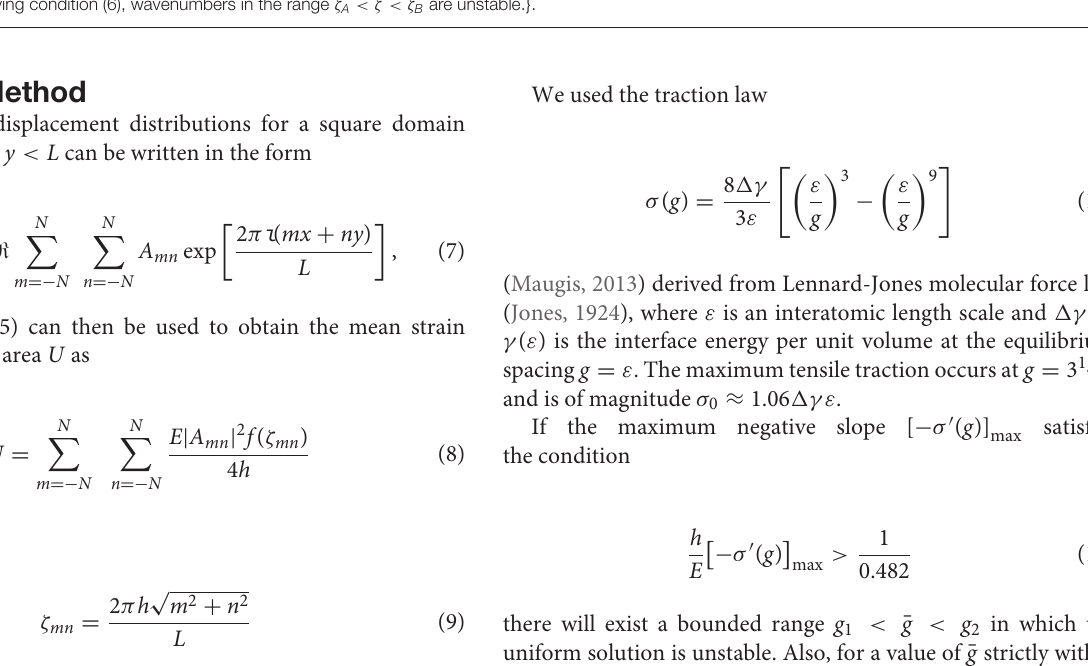
FIGURE 2 | Dimensionless layer compliance as a function of wavenumber for an incompressible elastic layer bonded to arigid foundation. For a given value of g )] satisfying condition (6), wavenumbers in the range ζ A < ζ < ζ B are E / h [ σ ′ ( ¯ −